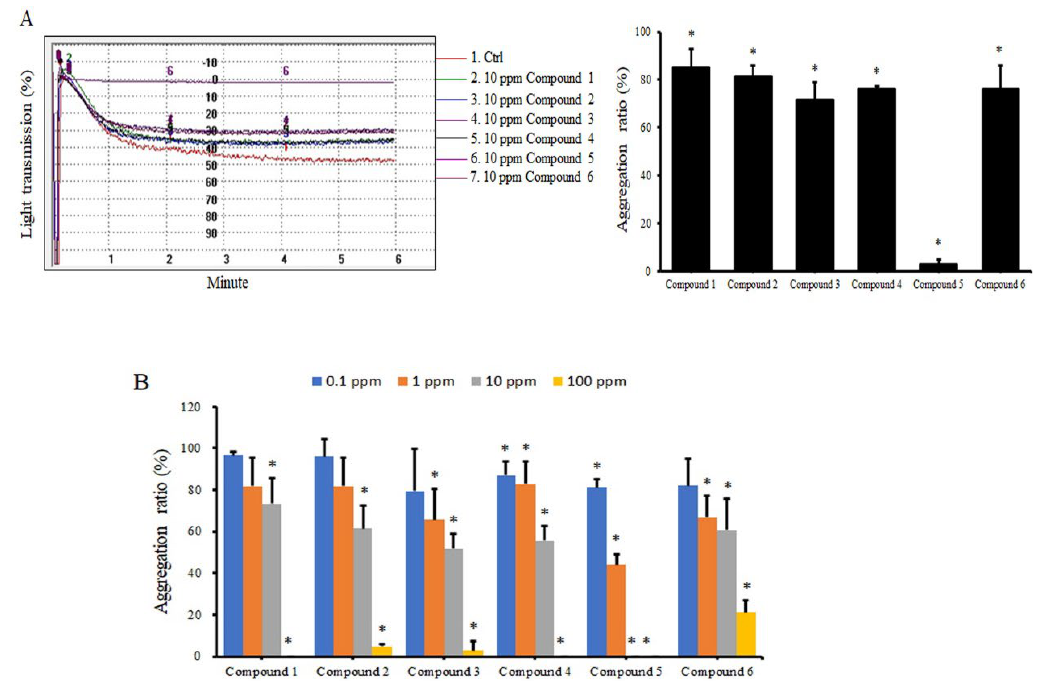
Figure 2. Effects of coumarin derivatives on ADP − induced platelet aggregation. Human PRP was treated with DMSO (control) or 10 ppm of coumarin derivates ( A ) or the indicated concentrations of coumarin derivatives ( B ) for 30 min, followed by addition of 10 μM ADP, and aggregation was analyzed using an aggregometer for 6 min. The data are presented as the aggregation ratio relative to control group treated with ADP only ( n = 3). * p < 0.05 compared with the control group treated with ADP only.